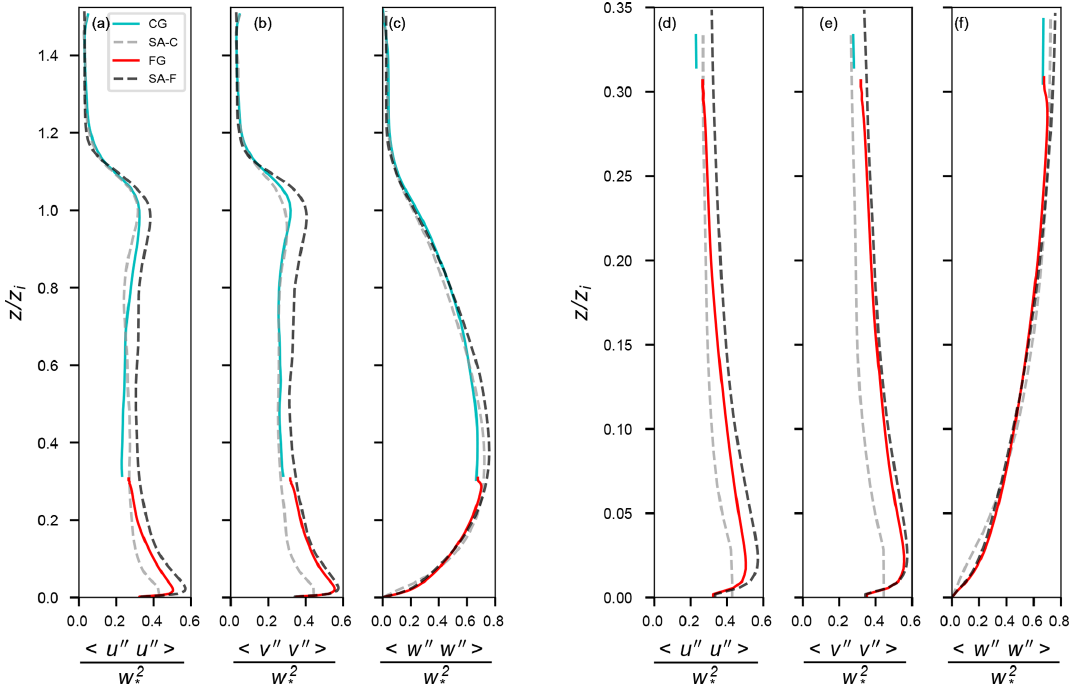
Figure 7. Vertical profile of horizontally averaged resolved variance of u (a, d) , v (b, e) , and w (c, f) normalized by w 2 ∗ . The variance of v and w shows better agreement with the stand-alone reference in the surface layer.